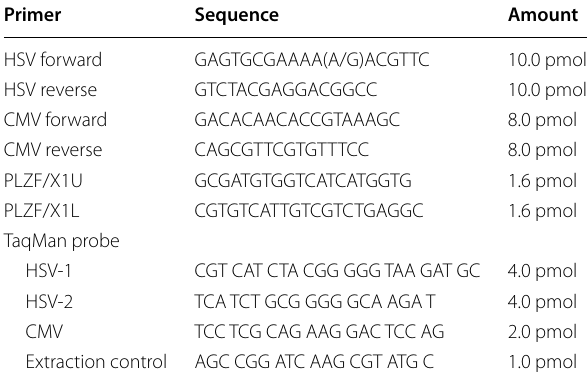
Table 1 Primer and TaqMan probes used for detection of